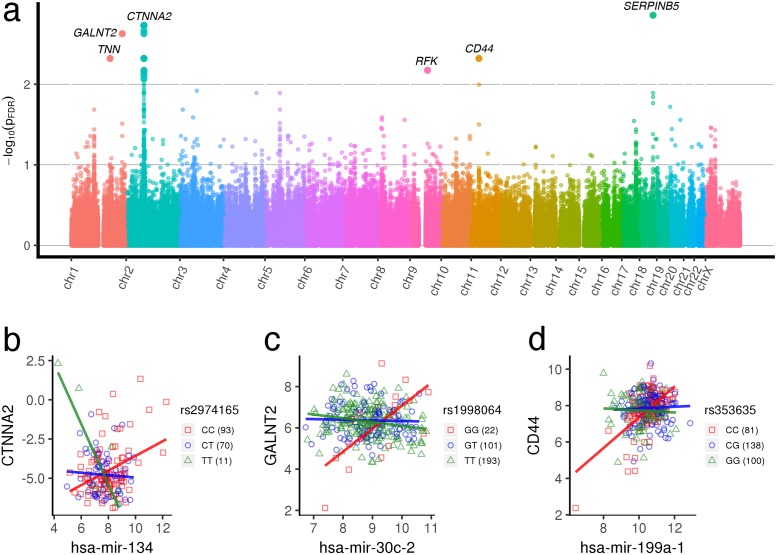
Lung cancer regQTLs.(a) Manhattan plot of regQTL −log10
FDR values in TCGA LUSC data. (b, c, d) Examples of lung cancer gene-miRNA-SNP trio with a significant regulatory difference across genotypes. All trio interactions pFDR < 0.015. More trios are indicated in S1 Text.